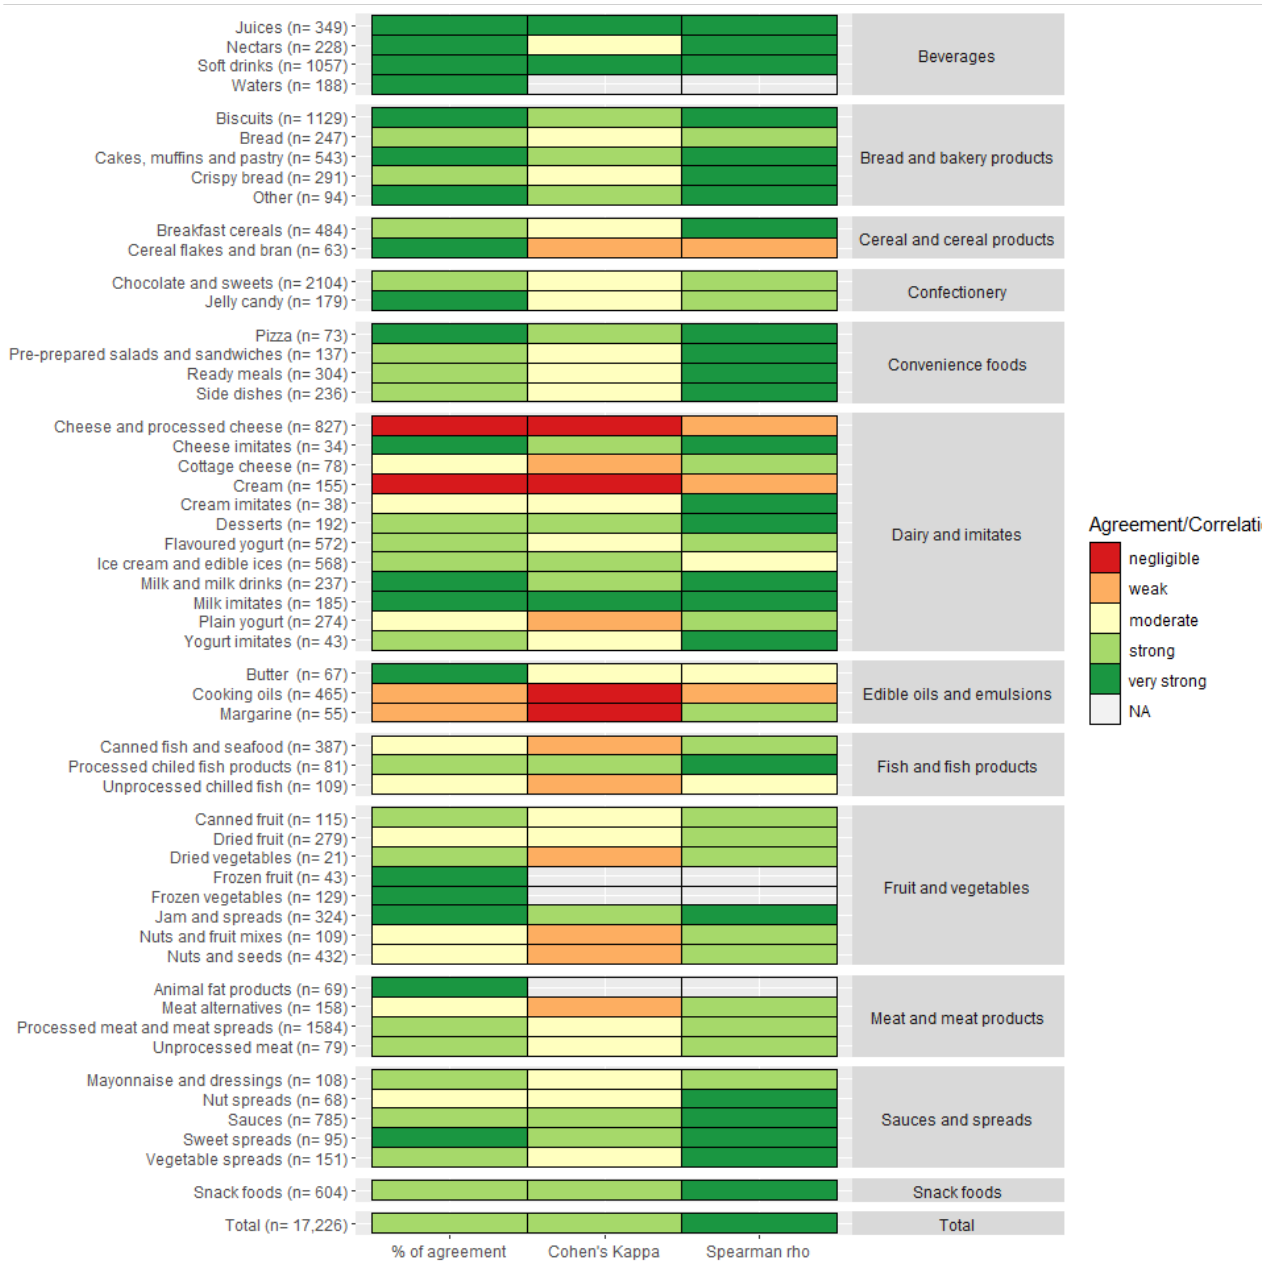
Figure 3. Agreement (% of agreement and Cohen’s Kappa) and correlation (Spearman rho) between Nutri-Score and Health Star Rating for subcategories. The main categories of the analysed subcategories are presented on the right. Cut offs ranges for agreement and correlations were as follows (multiplied by 100% for % of agreement): 0 – 0.20 negligible (red); 0.21 – 0.40 weak (orange); 0.41 – 0.60 moderate (yellow); 0.61 – 0.80 strong (light green); 0.81 – 1 very strong (dark green); NA — not applicable.